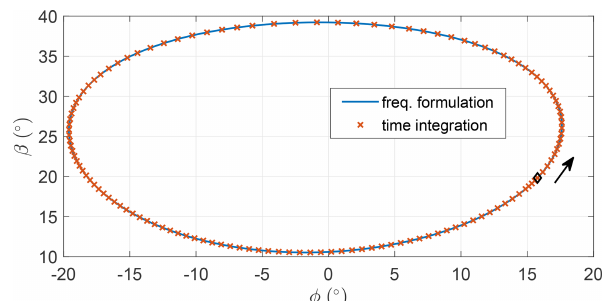
Figure B1. Azimuth and elevation of the trajectory found with the harmonic balance method and the time integration scheme for a circular-shaped trajectory.